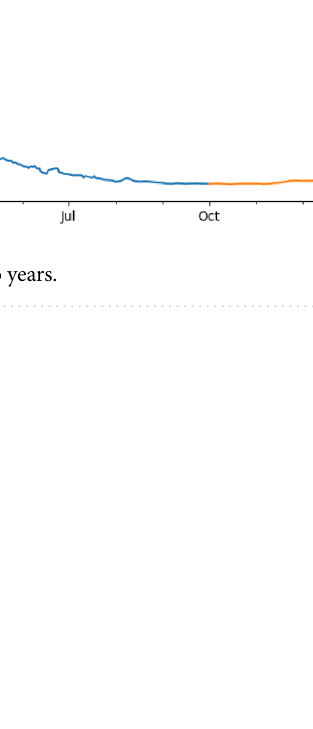
Figure 22. Predicting Kenya’s dengue cases using Peru and Brazil as the training